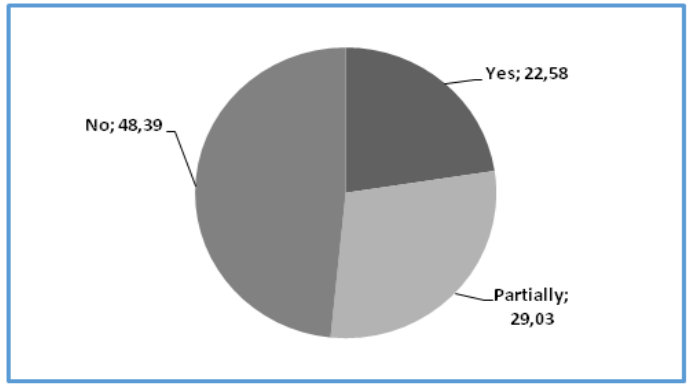
Fig. 2. Percentages of responses concerning the negotiation of